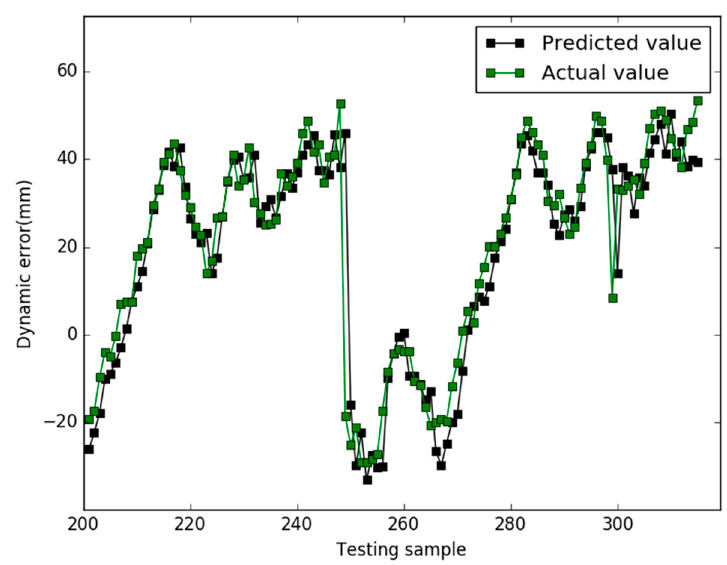
Figure 6. Predicted results of the PSO-SVM (case 2).